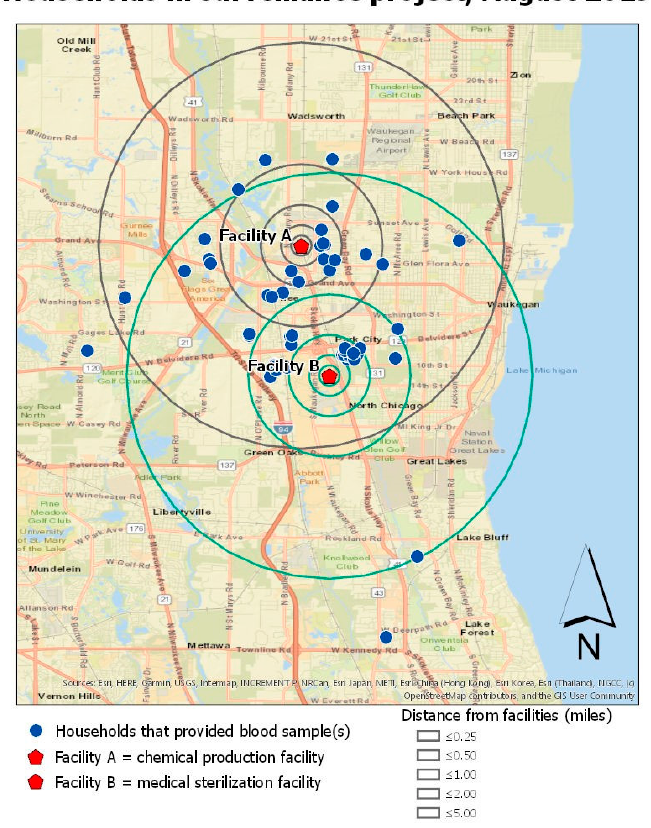
Figure 1. Map of households that participated in the surveillance project and their proximity to Facilities A and Facilities A and B.